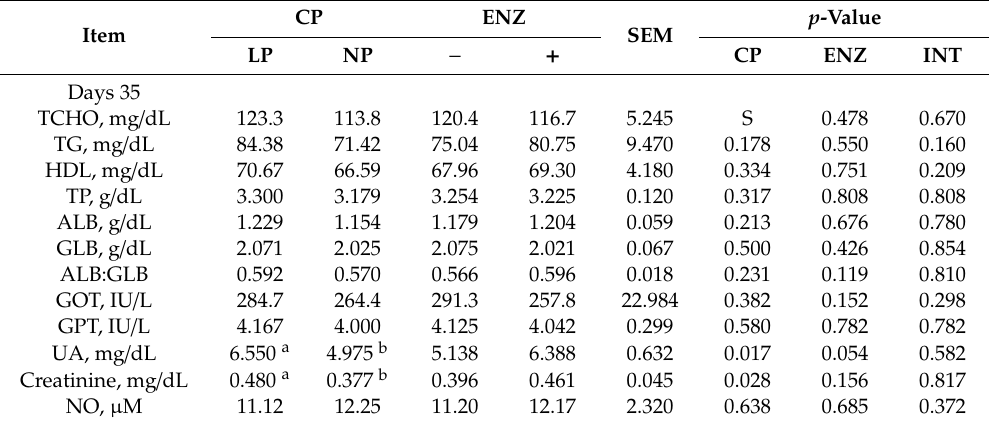
Table 9. E ff ect of low-protein diet and exogenous protease on serum biological parameters in broiler